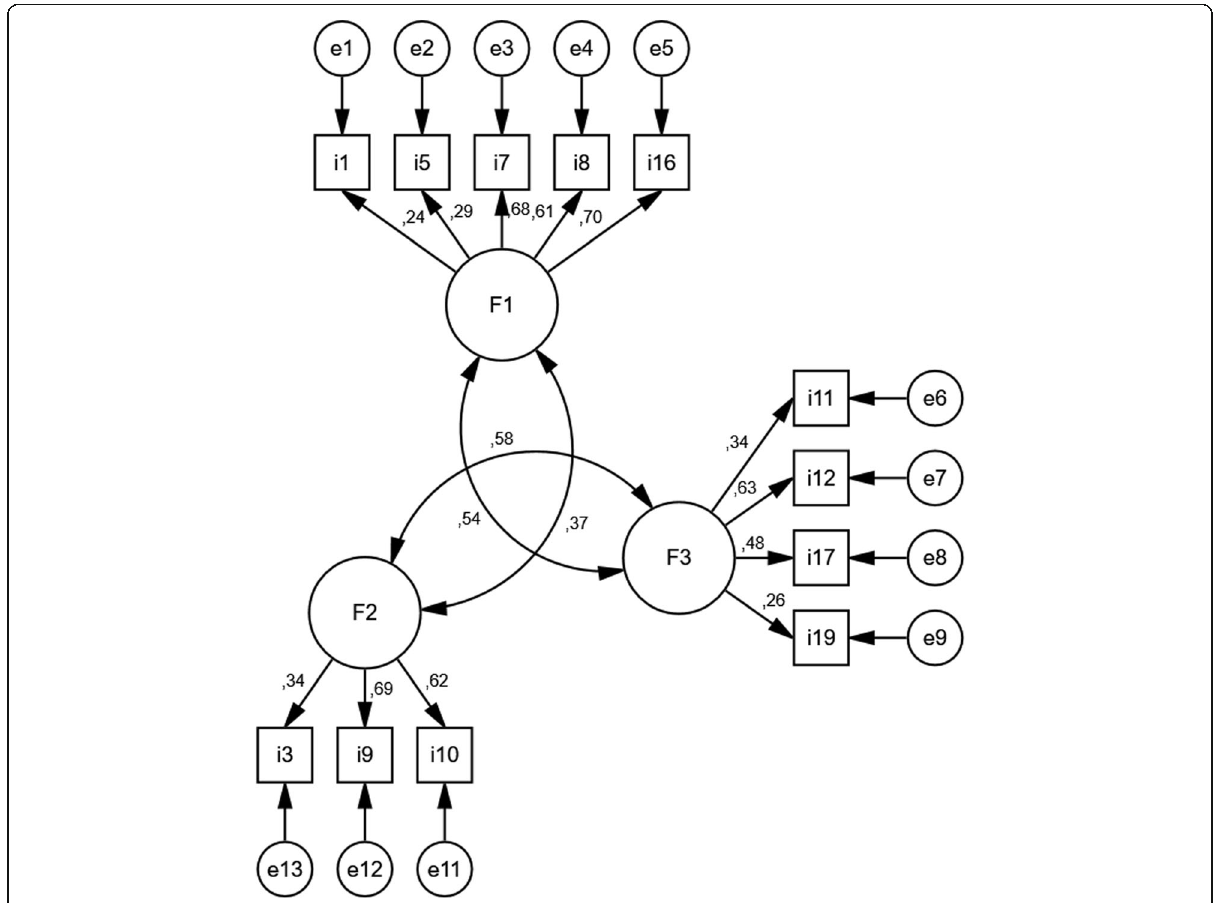
Fig. 1 Factor loading in a 3-factor solution under the ML method ( n